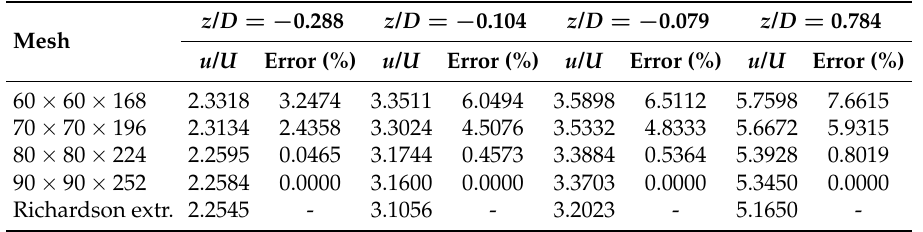
Table A1. Axial velocity and percentage error at Re D = 365, β = 1.97 and r / D = 0. z / D = − 0.288 z / D = − 0.104 z / D = − Mesh